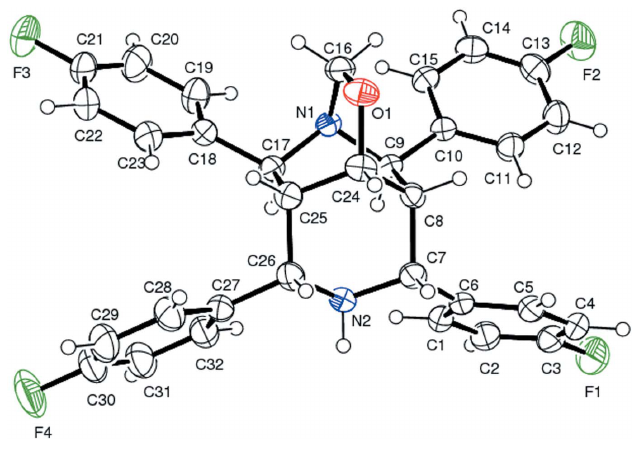
Figure 1 An ORTEP view of the title compound, showing the atom-numbering scheme. Displacement ellipsoids are drawn at 40% probability